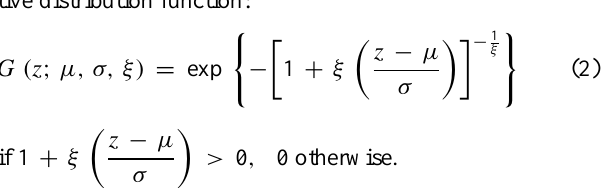
(left plot), the scale σ parameter (middle plot) or the shape ξ parameter (right plot). Lower panel: corresponding return level the location µ parameter (left plot), the scale σ parameter (middle plot) or the shape ξ parameter (right plot).